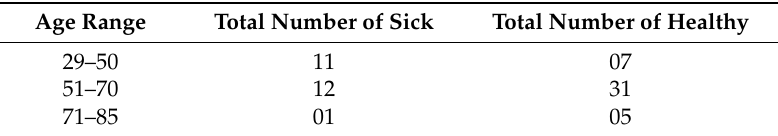
Table 2. Summary of subjects.